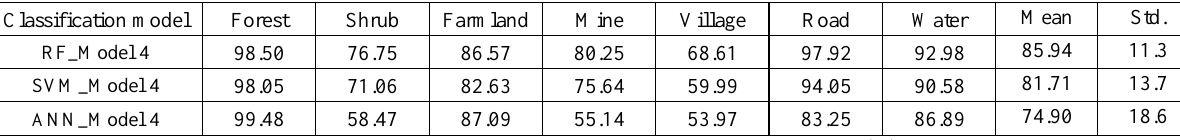
Table 5. Object types accuracy assessment of different method